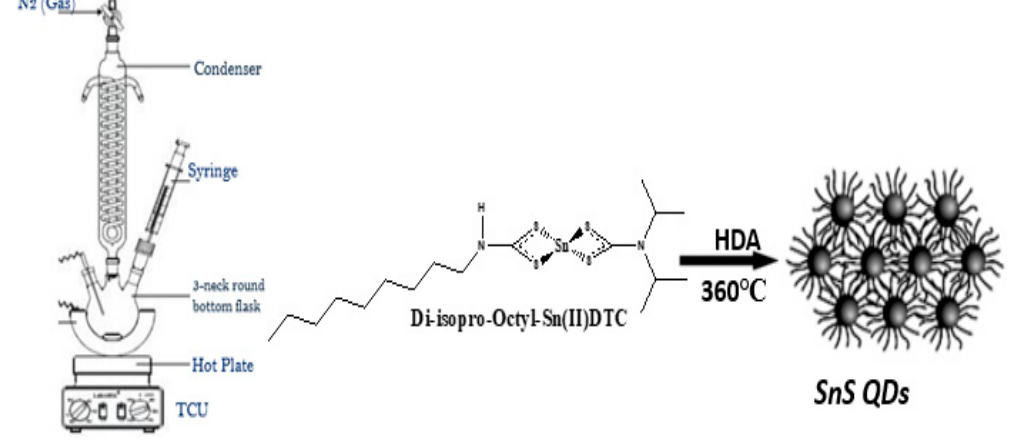
Figure 2. Schematic reaction of nanoparticles.